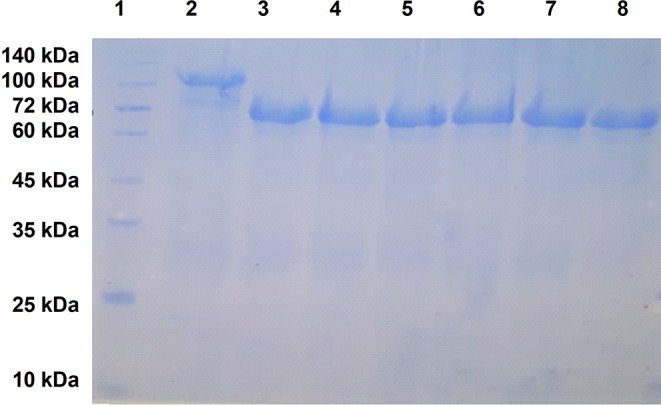
SDS-PAGE analysis of purified recombinant ZnuD and the hybrid antigens. Note that all antigens contain a N-terminal HisMbpTEV fusion partner thus are 40 kDa larger than the isolated protein antigen. Lanes; 1–MWS, 2–ZnuD, 3–Loop 2, 4–Loop 5, 5–Loop 7, 6–Loop 11, 7–Loop 25711 (all loops), 8–LCL.